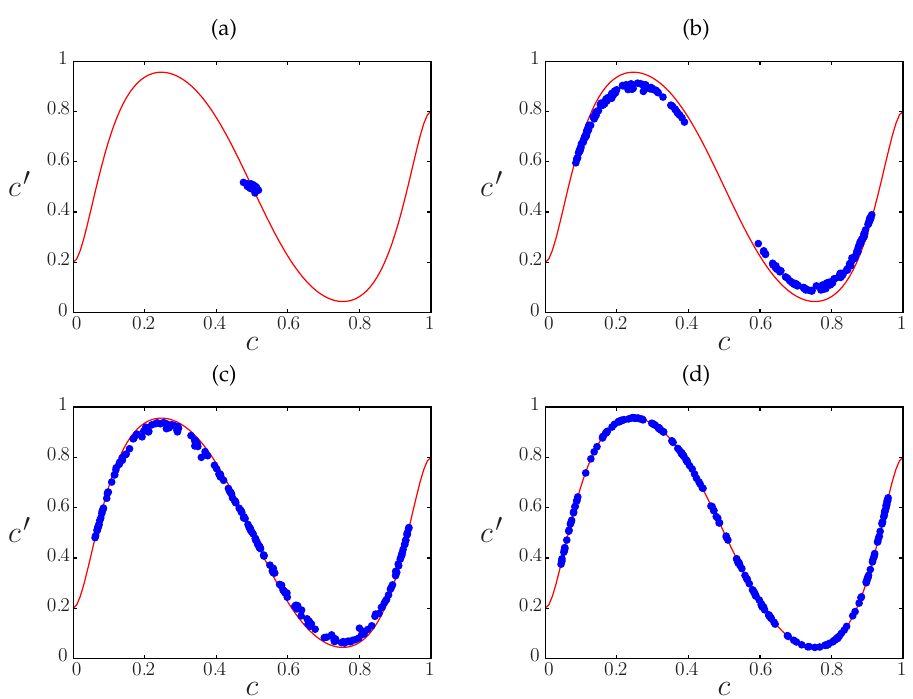
Figure 13. Return map of the average opinion c on small-world networks for several values of the long-range connection probability p with J = 6, k = 20, N = 10 3 , and a transient of 10 3 time steps. − The following 200 iterations are shown as (blue, darker) dots. The (red, lighter) continuous curve is Equation (9). ( a ) p = 0.0, ( b ) p = 0.5, ( c ) p = 0.6, and ( d ) p = 1.0. Figures from